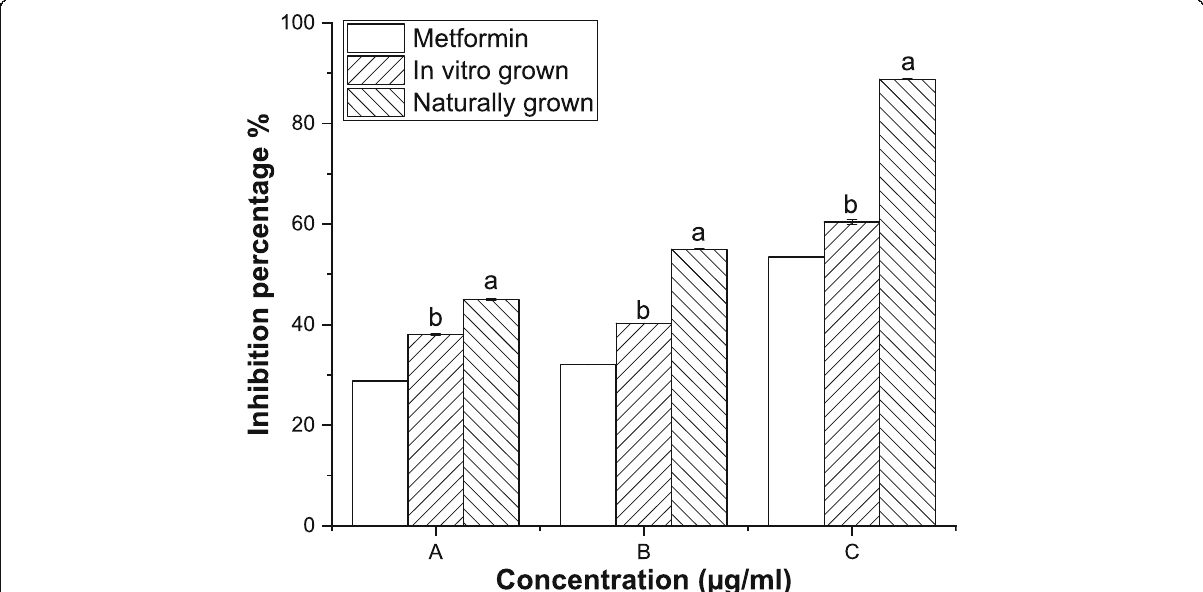
Fig. 6 α -amylase inhibitory activity of in vitro and naturally grown L. cruciata and their comparison with standard Metformin . Values with different letters (a, b) are significantly ( p < 0.05) different from each other by Turkey ’ s multiple range test